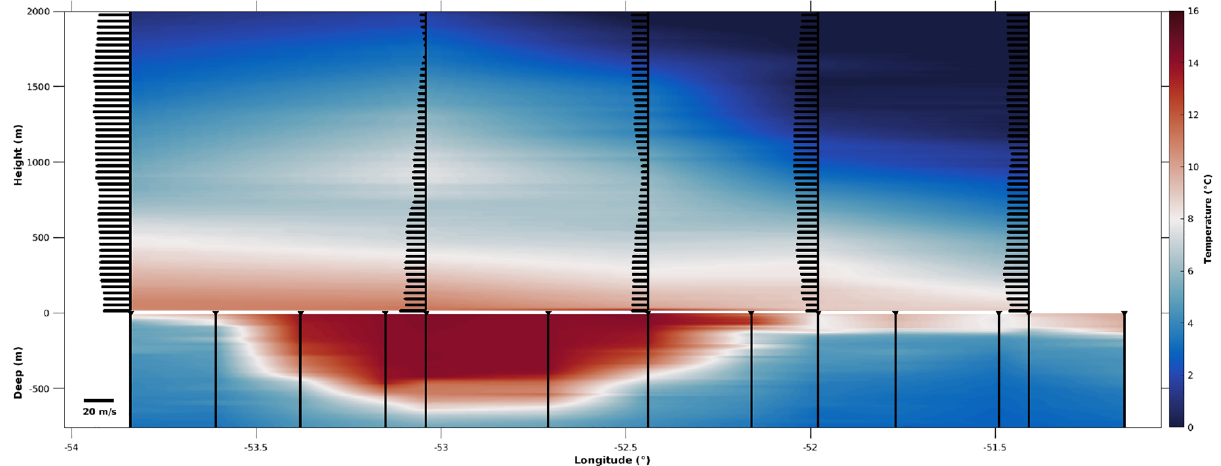
Figure 3. Temperature profiles (°C) of the atmosphere and ocean (colors) taken simultaneously by radiosondes and XBTs along the Brazilian Navy Polar Vessel (Po/V) Almirante Maximiano (H-41) route while crossing the eddy during 18 th October 2019. The lower part of this figure also displays the oceanic sounding positions. Wind magnitude (m s -1 ) in vectors is also displayed, superimposed on the air temperature. The vector size reflects the